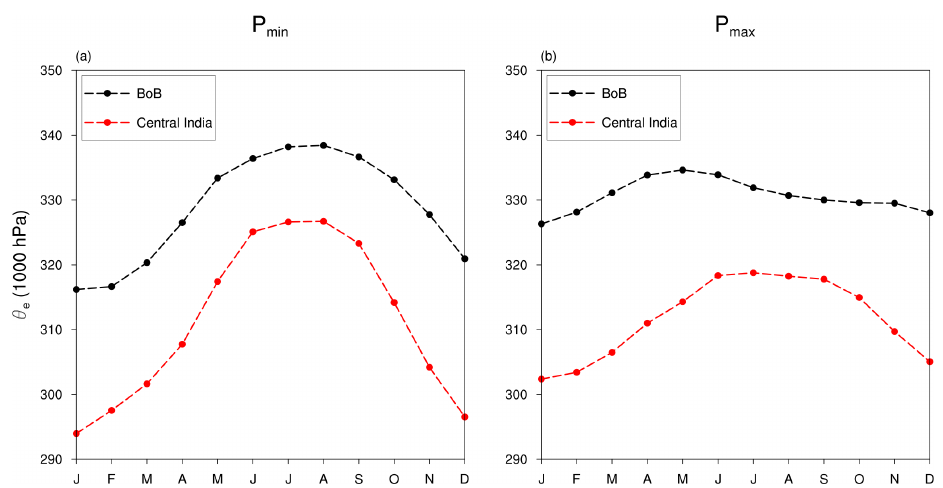
Figure 7. The seasonal cycle of near-surface equivalent potential temperature ( θ e ) for India and the Bay of Bengal for the (a) P min configu- ration and (b) P max